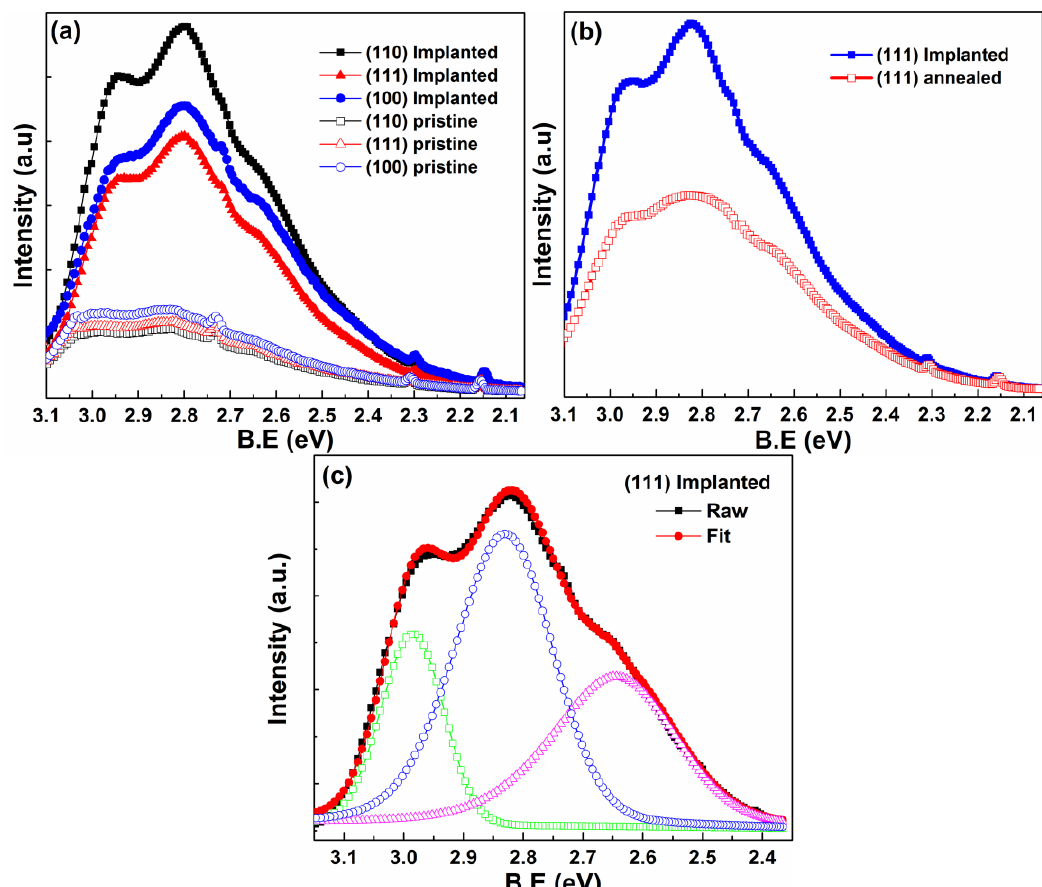
Figure 5. ( a ) PL of as-implanted samples with different orientation. ( b ) PL of as-implanted sample before and after annealing in air. ( c ) Gaussian fit of PL spectra for (111) implanted MgO sample.